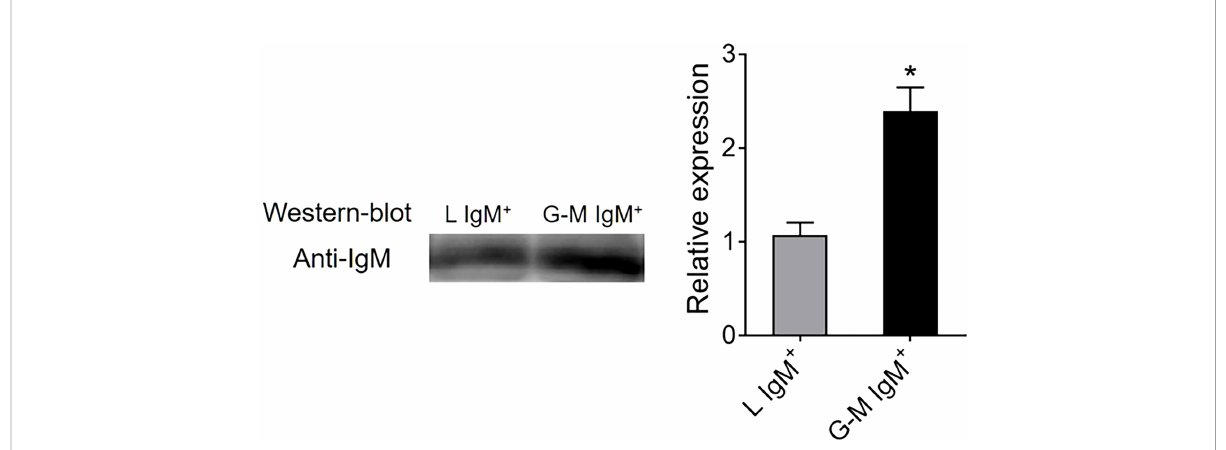
FIGURE 4 Detection of IgM secretory capacity between tilapia L-gate IgM + and G-M gate IgM + cells. L-gate IgM + and G-M gate IgM + cells were sorted from tilapia anterior kidney (AK) leukocytes using a BD FACSAria ™ III fl ow cytometer, before being plated in fl at-bottom 96-well plates in 200 m l of Roswell Park Memorial Institute (RPMI)-1640 medium supplemented with 10% fetal bovine serum (FBS) and 100 units/ml penicillin and 100 m g/ml streptomycin (P/S). After being cultured in vitro for 72 hours at 25°C, the supernatants were collected to measure the amount of secreted IgM using western blotting ( n = 3 fi sh). * p ≤